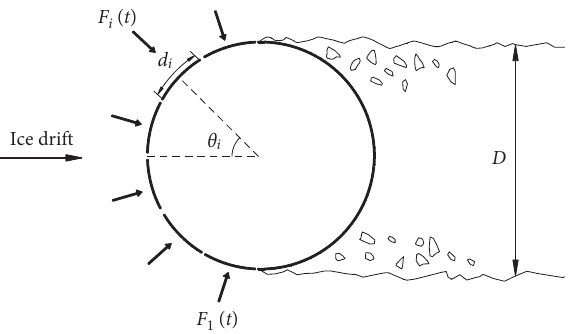
Figure 9: Ice forces distribution on an offshore